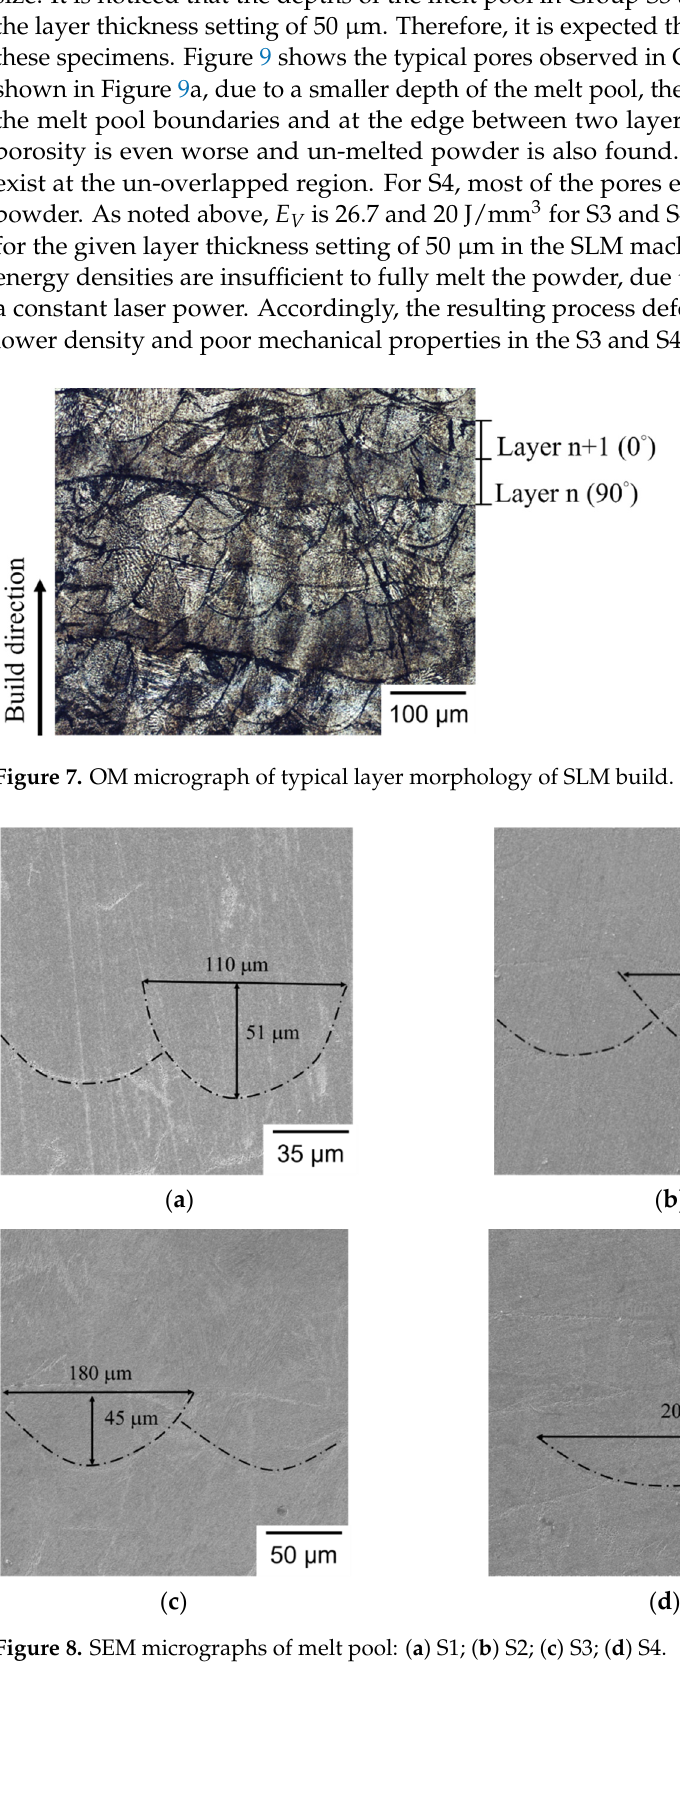
. ( a ) ( b ) Figure 9. Micrographs of typical pores observed in ( a ) S3 (OM) and ( b ) S4 (SEM). In our earlier study [26], martensite and retained austenite are the two main phases existing in the as-built SLM AISI 420 stainless steel. For martensitic stainless steel parts fabricated by SLM, retained austenite also exists in the as-built state, which is attributed to the high cooling rate experienced in SLM process, in a way similar to the quenching process. During the cooling process, the melt pool rapidly solidifies to form the oriented austenite ( γ phase) grains, such that most of the retained austenite is nearly parallel to the build direction. When the temperature decreases to the starting point of martensite trans- formation ( M s ), the solidified melt pool is transformed into martensite ( α ’ phase), in a lath structure [31]. To identify the crystalline phases in the SLM builds of AISI 420 fabricated in this study, Group S1 was selected as a representative for XRD analysis, as the specimens in this group have the highest density among the given SLM builds. Note that the existing pores may affect the accuracy of XRD analysis, such that S1, having the lowest porosity, was selected. The XRD analysis results confirms that only martensite and retained austen- ite, indeed, exist in the as-built SLM builds of AISI 420 in this study. The volume fraction of the retained austenite was then determined using the XRD results. Details of the calcu- lation procedure for determining the volume fraction of retained austenite were given in our earlier study [26]. In this way, the volume fraction of retained austenite in Group S1 is determined as 32%, and the remaining 68% is martensite. The content of martensite is more than twice that of austenite, resulting from a rapid cooling rate in the SLM process. During the cooling process, most of the austenite transforms to martensite at the temper- ature range between the martensite-start temperature and martensite-finfish temperature. However, a certain amount of austenite does not transform to martensite, so about 30% of austenite is detected in the specimens, namely retained austenite.